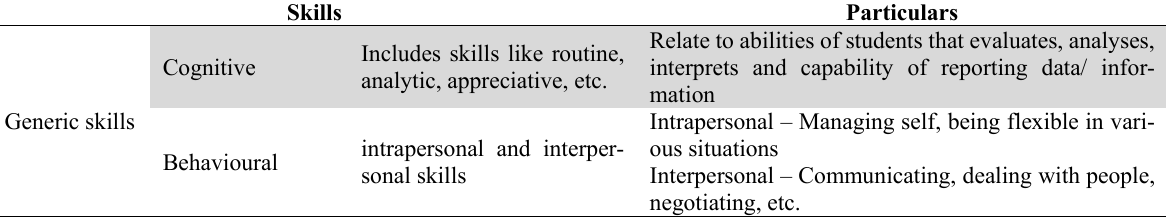
Relate to abilities of students that evaluates, analyses, interprets and capability of reporting data/ infor- mation Intrapersonal – Managing self, being flexible in vari- ous situations Interpersonal – Communicating, dealing with people, negotiating, etc.